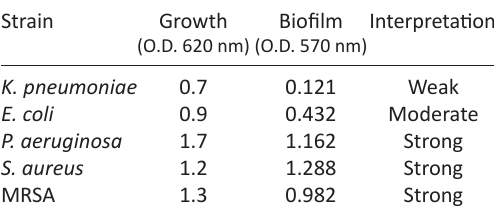
Table 4. Determination of biofilm formation by tissue